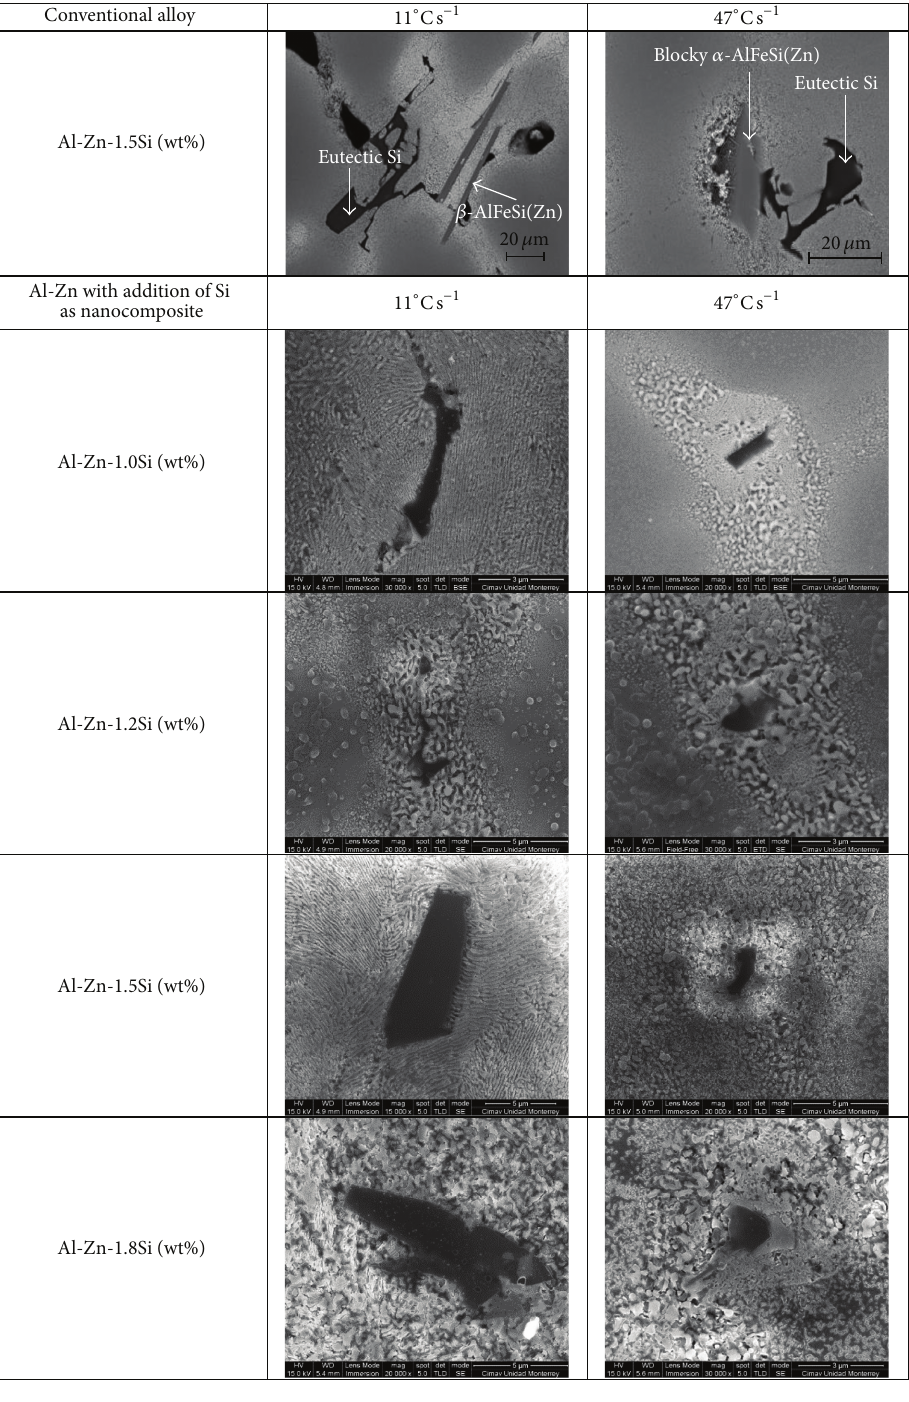
Figure 8: Electron images illustrating a comparison of the morphology of silicon particles in Al-Zn-Si alloys solidified at low and high cooling